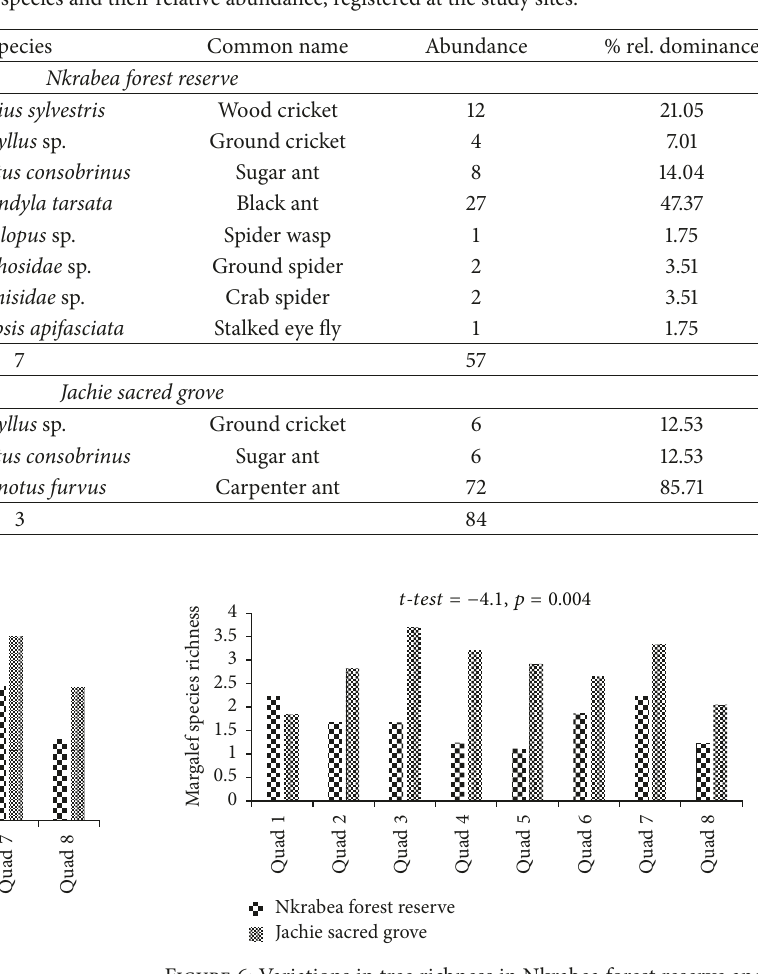
Figure 5: Comparison of variations in tree diversity in Nkrabea forest Reserve and Jackie sacred grove.